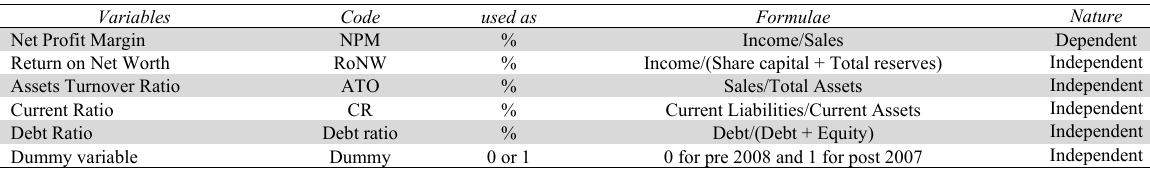
Variables used in the study